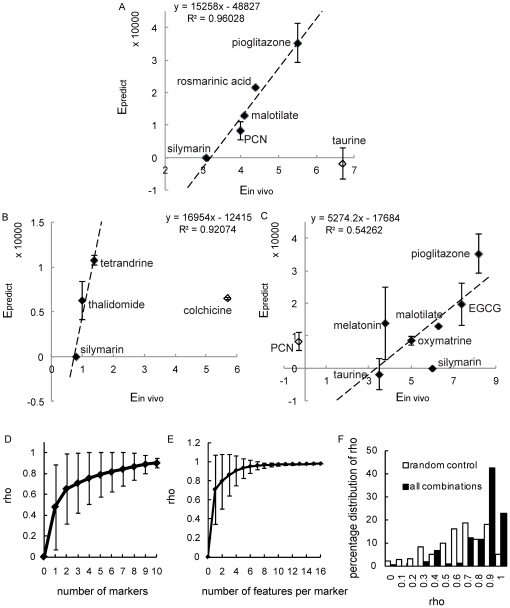
Correlation between Epredict and Ein vivo.(A) Optimization of Epredict. Epredict is computed as a weighted combination of the features with weights optimized using Spearman's rank correlation test to best correlate with Ein vivo from the CCl4 treatment model. (B, C) Blind validations of in vitro-in vivo correlation between Epredict and Ein vivo from two independent datasets containing DMN treatment and CCl4 preventive models respectively. The linear relationship is highlighted using linear regression lines in all (A, B and C). The equations of the linear regression lines and the R2 values are computed without considering the outliers in the graphs (i.e., taurine in A, colchicine in B and PCN in C). (D) The relationship between the average rho value and the number of markers. (E) The relationship between average rho and the number of features per marker. Error bars represent standard deviation. (F) The percentage distribution of rho is plotted for all possible combinations of the 3 weights and 10 markers. The random control was done by randomizing the relative ranks of the in vivo drug efficacies for the Spearman's rank correlation test.